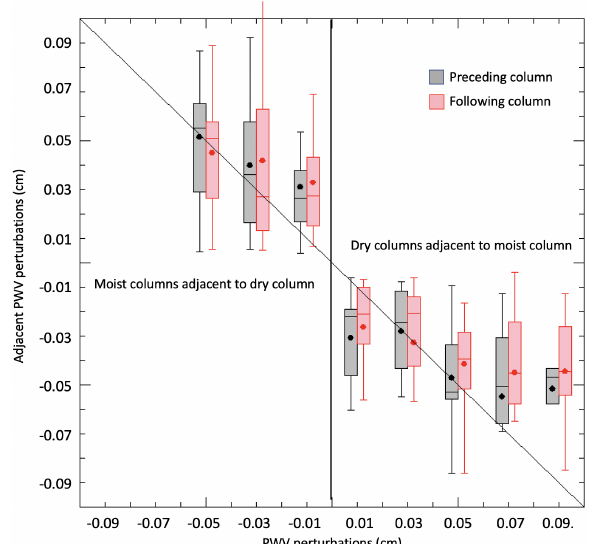
Figure 8. Average water vapor perturbations in the columns pre- ceding (black) and following (red) a central perturbation identified on the x axis. The diagonal line indicates the point where vapor perturbations in adjacent columns have the same magnitude as the central column: N = 25, 22, 19, 15, 20, 15,13, and 5 for a total of 134 points. The nine missing cases are distributed in the bins below − 0 . 05cm and above 0.09cm with fewer than five points in each